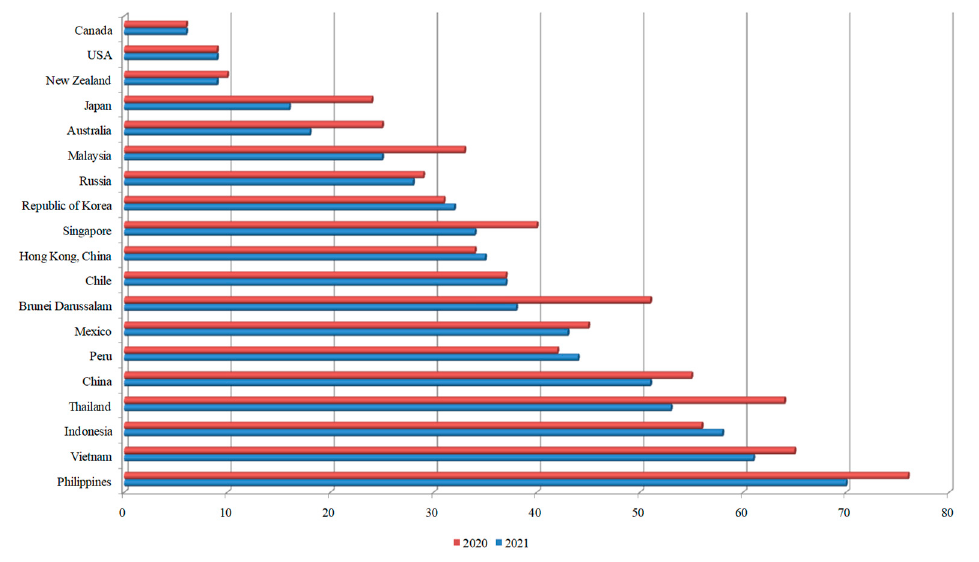
Figure 1. APEC member economies’ places in the World Energy Trilemma Index for 2020–2021. Source: [47,48]. Used by permission of the World Energy